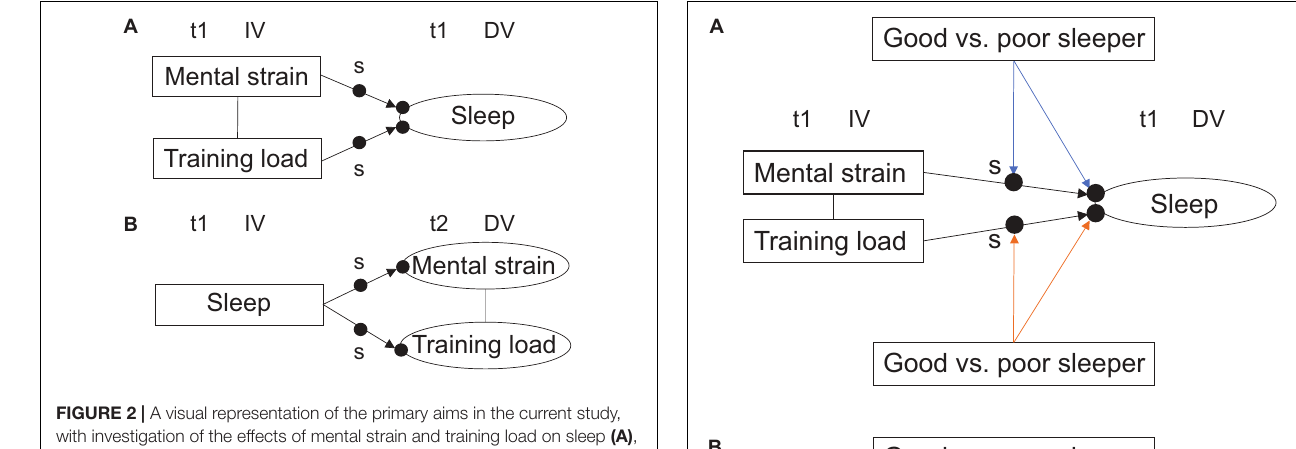
Training diaries